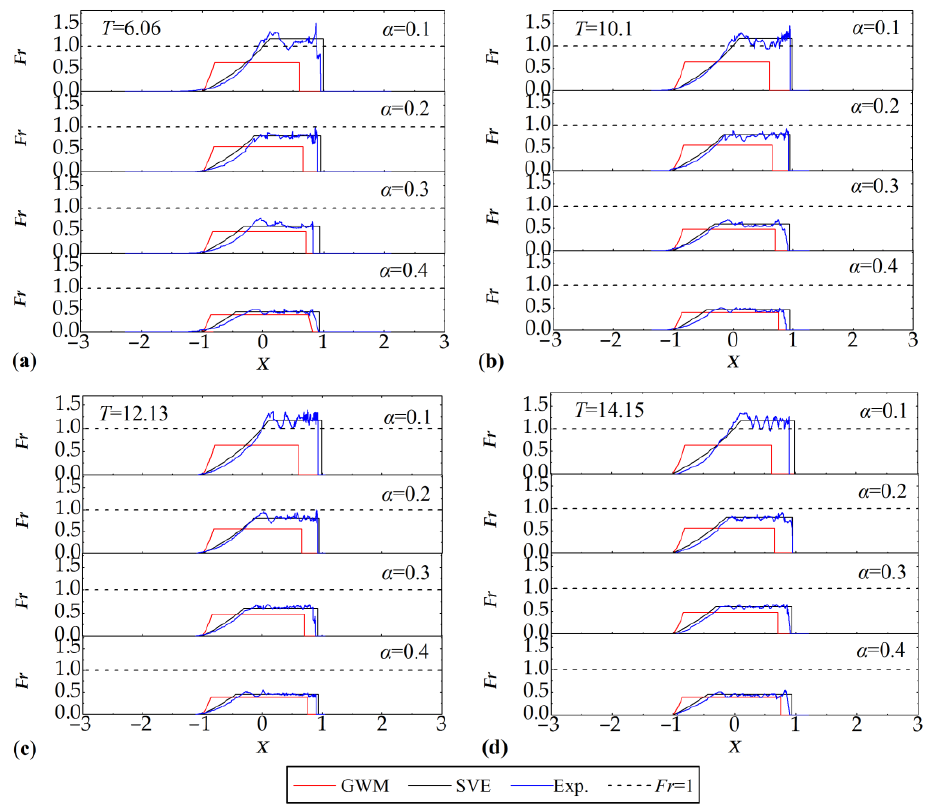
Figure 11. Fr for wet bed downstream: ( a ) T = 6.06; ( b ) T = 10.1; ( c ) T = 12.13; ( d ) T = 14.15.